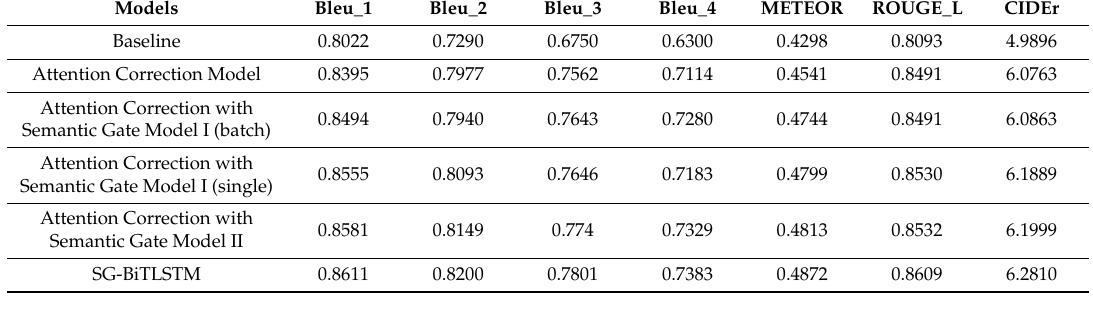
Table 2. Bleu indicators of the models.